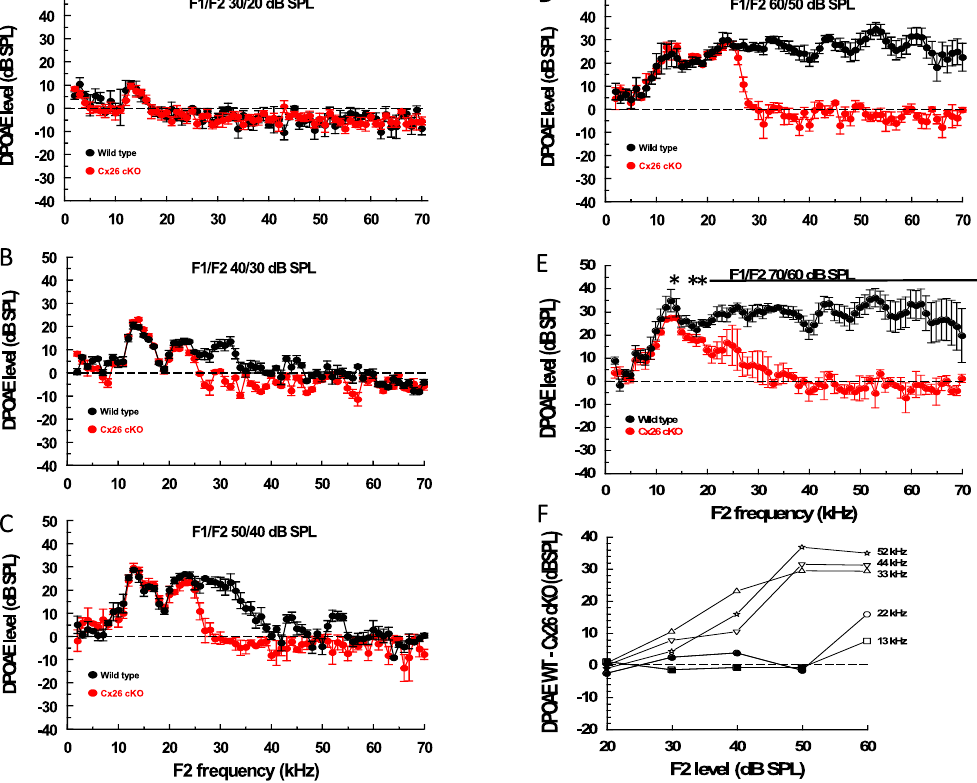
Figure 4. Low-frequency DPOAE responses are similar in WT and Cx26 cKO mice. ( A – E ) DPOAE isolevel audiograms (DPOAE 2f1 − f2 magnitude, mean ± SD,) as a function of the f2 frequency (f2 levels: A = 20 dB SPL, B = 30 dB SPL, C = 40 dB SPL, D = 50 dB SPL, E = 60 dB SPL; f2/f1 ratio = 1.23; level of f2 set 10 dB below f1 level) from 5 WT (black symbols) and 5 Cx26 cKO (red symbols) mice. Dashed lines indicate measurement noise floor. Solid horizontal lines and asterisks indicate regions and points, respectively, where DPOAEs from WT and Cx26 cKO mice are significantly different (unpaired t-test, 0.05 two-tailed p value). F. Difference in mean magnitude between DPOAEs measured from WT and Cx26 cKO mice (obtained from data presented in Fig. 4A–E) at different frequencies, shown in Fig. 4F, as functions of f2 level. Solid symbols indicate measurements where there is no significant difference between measurements made from WT and Cx26 cKO mice (unpaired t-test, 0.05 two-tailed p High frequency hearing is desensitized and low-mid frequency hearing is sensitized in Cx26 cKO mice. Distortion product otoacoustic emissions (DPOAEs) are nonlinear acoustical responses produced by the cochlea when stimulated simultaneously with two pure tones (f1 and f2, f1 < f2) with optimal frequency ratio and level differences 26 (caption, Fig. 4). It is generally accepted that the recording of DPOAEs indicates that OHCs provide cochlear amplification. The background strain of Cx26 cKO mice is not particularly sensitive and DPOAE audiograms measured from both the WT and Cx26 cKO littermates with the level of f2 equal to 20 dB SPL are indistinguishable from each other. With f2 level set at 20 dB SPL, DPOAEs are at or close to the recording noise floor across the whole frequency range of the experiment (f2 = 2–70 kHz) except for a small peak close to 13 kHz (Fig. 4A). With increasing level of f2 from 20 dB SPL to 50 dB SPL, DPOAEs appear above the noise floor and the audiogram extends upwards in frequency with increasing SPL (Fig. 4B–D). With increasing f2 level the audiograms from WT mice extend upwards in frequency to the upper limit of the f2 stimulus range (70 kHz). The audiograms of Cx26 cKO mice are indistinguishable from those of their WT littermates for frequencies just below 25 kHz at all f2 levels at or below 50 dB SPL. Above this frequency, DPOAEs recorded from Cx26 cKO mice decline rapidly to the noise floor at ~30 kHz (Fig. 4B–D). As can be seen, this rapid decline in DPOAEs is a step-wise and not a gradual, frequency-dependent process. Lines and asterisks in Fig. 4 indicate frequency regions where the audiograms of Cx26 cKO mice and their WT littermates are significantly different (unpaired t-test, 0.05 two-tailed p value). The audiograms of both the WT and Cx26 cKO littermates change at f2 levels of 60 dB SPL. The audiograms of the WT mice show greater variation at the highest frequencies, as indicated by the increased size of the standard deviations (Fig. 4E). Audiograms from the Cx26 cKO littermates do not closely resemble those of their WT littermates, but decline gradually, and with variability between preparations (note standard deviations, Fig. 4E) from 13 kHz to the noise floor at 30 kHz. Similarities and differences in the audio- grams recorded from WT mice and the Cx26 cKO littermates are shown in Fig. 4F. This represents the difference (WT–Cx26 cKO) of the mean amplitude values of the audiograms at 5 representative f2 frequencies at all f2